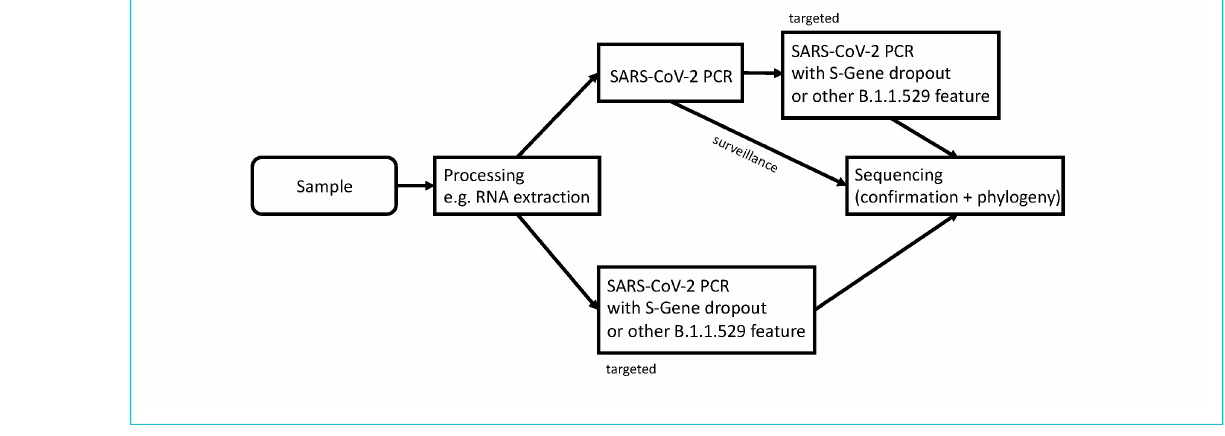
Figure 2: Workflow for screening and confirmation of the SARS-CoV-2 Omicron variant. “Surveillance” indicates the routine workflow for how Omicron variants could be detected by the sequencing surveillance program coordinated via CRIVE and the FOPH. “Targeted” indicates a suspected case of an Omicron variant which should be confirmed via